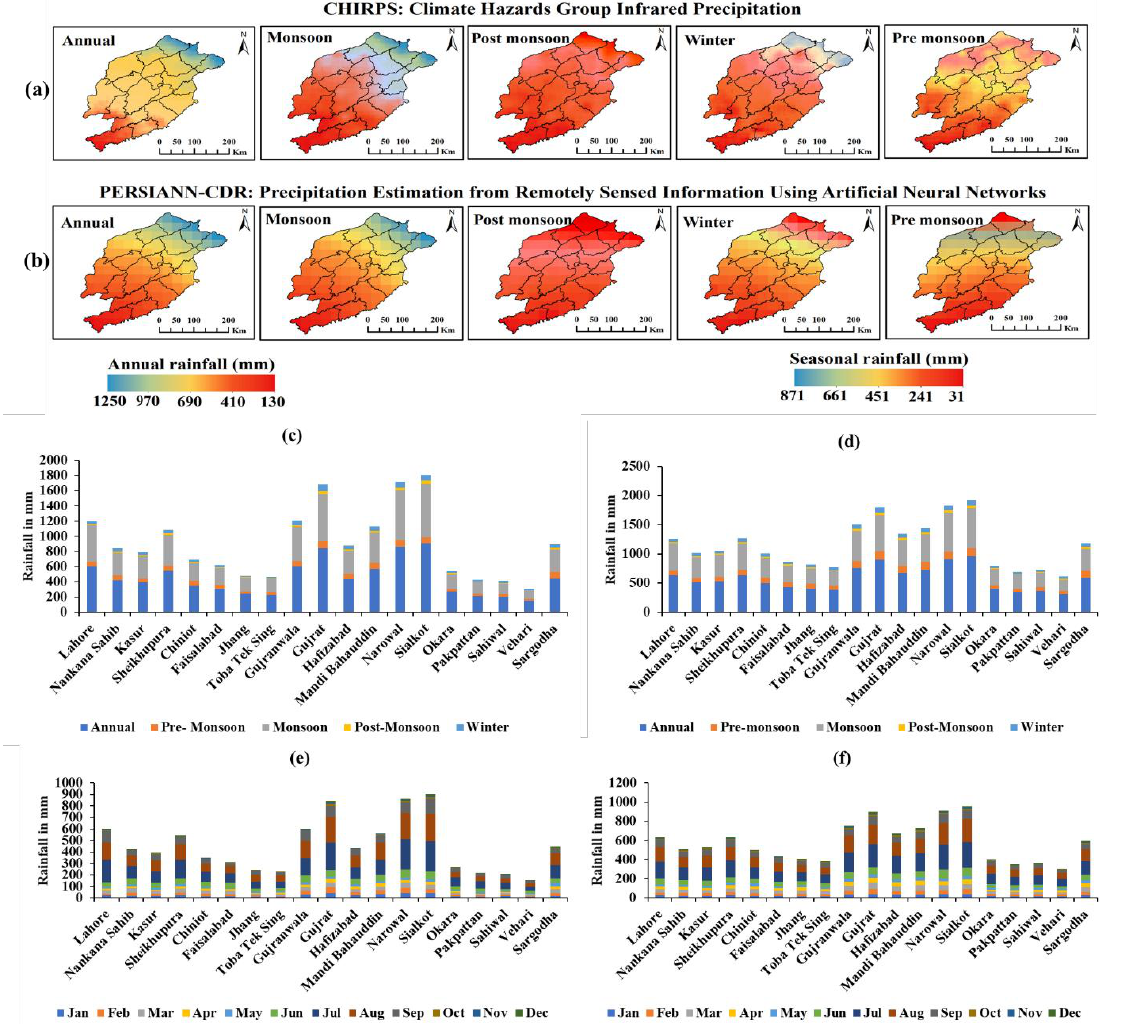
Figure 4. Spatial distribution of mean seasonal and annual rainfall. The upper panel shows ( a ) CHIRPS, and the lower panel displays ( b ) PERSIANN-CDR. Middle and lower portions show district-wise distribution of annual, seasonal, and monthly rainfall (1983 – 2020). ( c ) Mean annual and seasonal rainfall of CHIRPS; ( d ) mean annual and seasonal rainfall of PERSIAN-CDR; ( e ) mean monthly rainfall of CHIRPS; ( f ) mean monthly rainfall of PERSIANN-CDR.